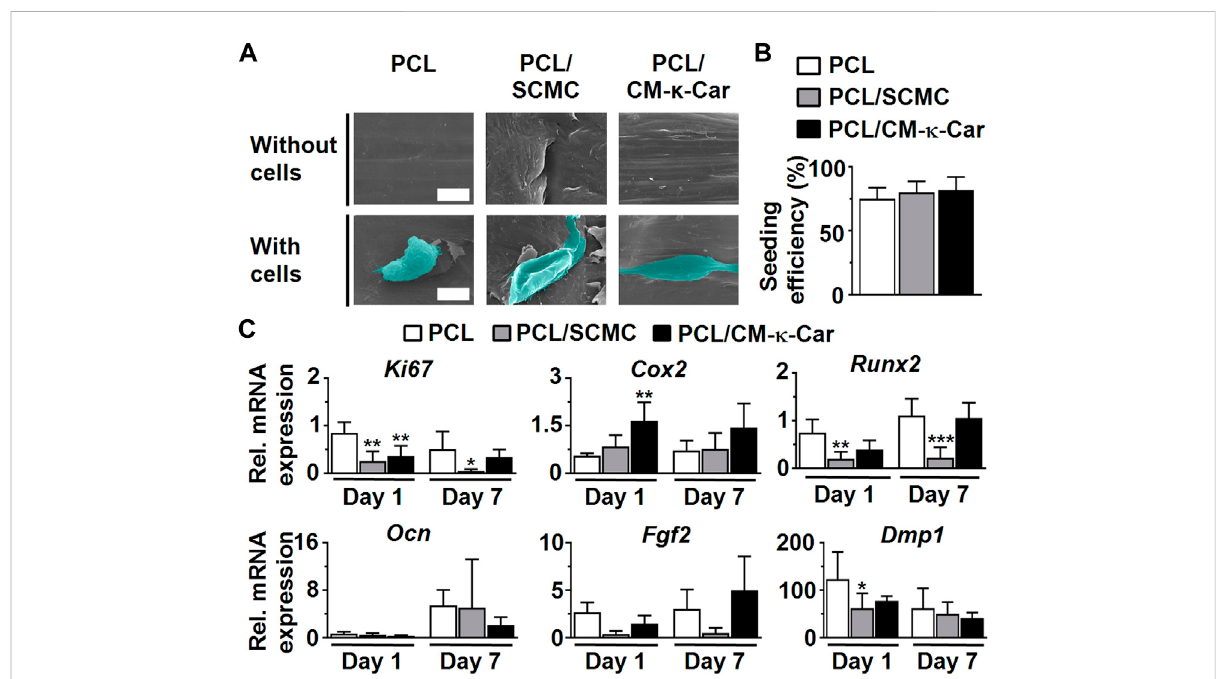
FIGURE 5 Effect of 3D-printed PCL scaffold surface-functionalization by SCMC or CM- κ -Car on MC3T3-E1 pre-osteoblast spreading, attachment, and gene expression. (A) SEM images showing pre-osteoblast morphology and spreading after 4 h. Scale bar: 10 µm. (B) Pre-osteoblast seeding ef fi ciency. (C) Expression of osteogenic ( Runx2 , Ocn , Dmp1 ), proliferation ( Ki67 ), and angiogenic-related ( Fgf2 )genes by MC3T3-E1 pre-osteoblasts after 1 and 7 days. Values are normalized to Pbgd expression. Values are mean ± SD ( n = 3). *Signi fi cantly different from unfunctionalized